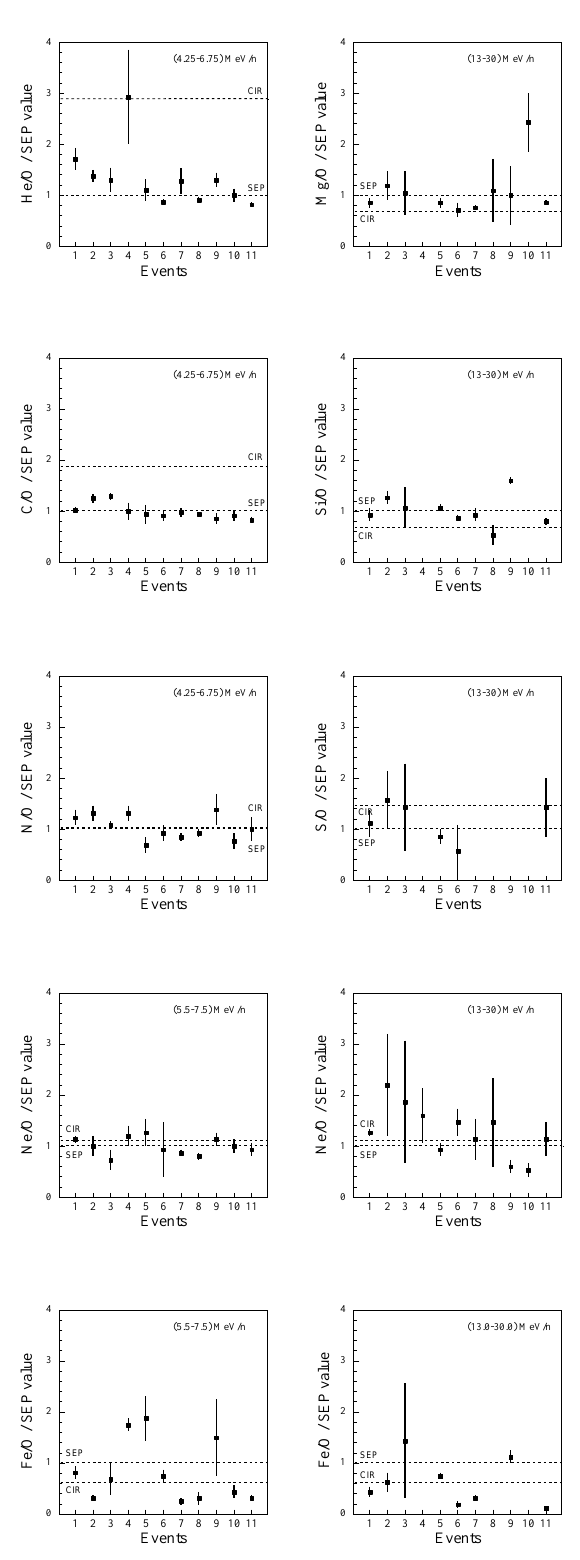
Fig. 5. Elemental abundance ratios with respect to the corresponding reference SEP values as recorded by the Ulysses COSPIN/LET instrument averaged during eleven selected time periods during the solar maximum mission from the solar polar passages in 2000 / 2001 to May in 2002 (left: energy range 5 . 5–7 . 5 MeV/n; right: 13.0–30.0